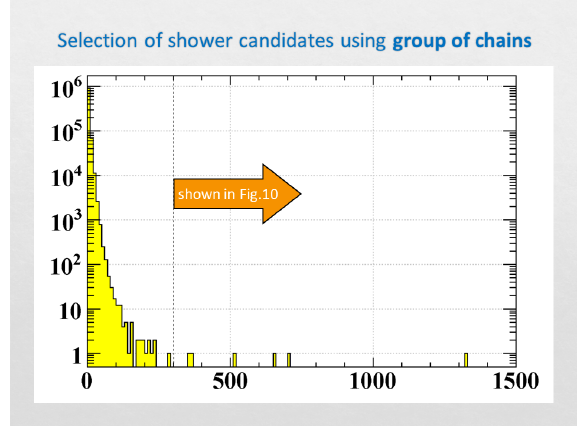
Fig 9. The histogram shows how many base-tracks each group of chains has. Those group of chains having are selected and those base-tracks are shown in Fig.10.